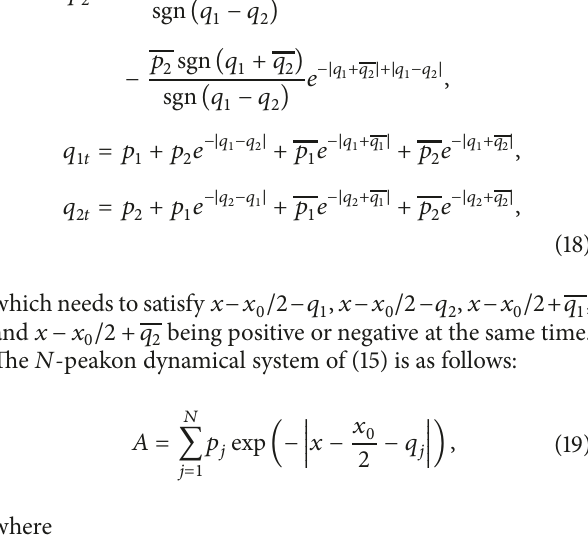
where 𝑝 1 , 𝑝 2 , 𝑞 1 , 𝑞 2 are real function with respect to variable